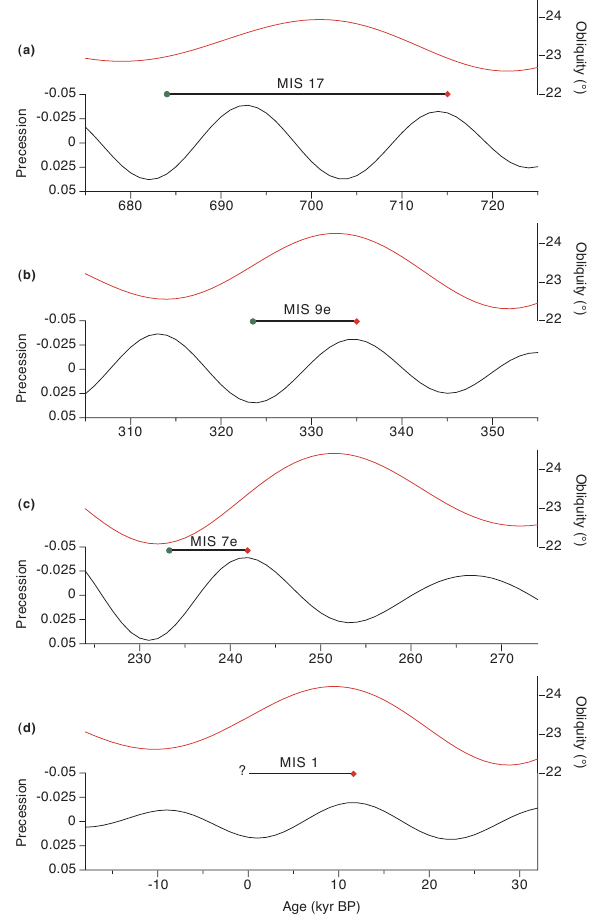
Fig. 12. Phasing of precession and obliquity (Laskar et al., 2004) in relation to interglacial duration (indicated by horizontal